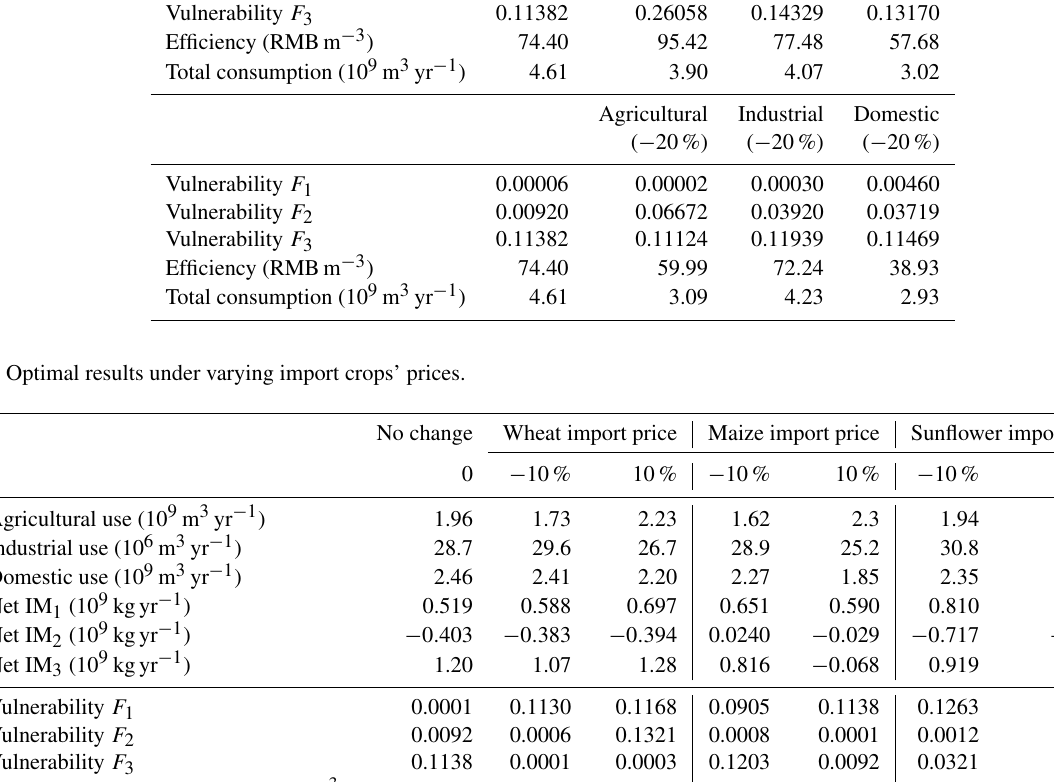
Table 5. Objective values and total consumption for the 10% and 20% reductions in water demand.